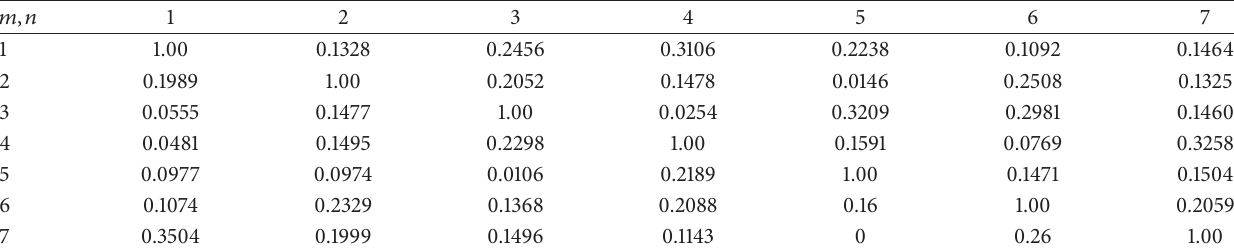
Table 2: Correlation matrix for UIC (lower/upper triangular part: